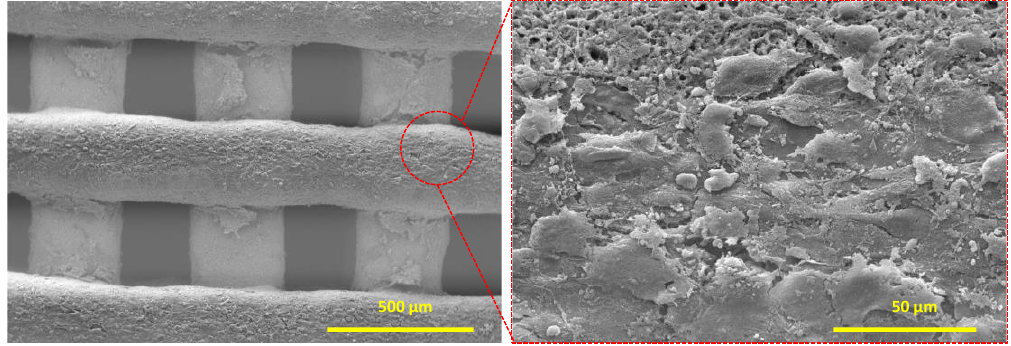
Figure 5. Surface structure of Au-scaffold sensor after incubation of MG-63 cells (10 6 cells/ scaffold) .